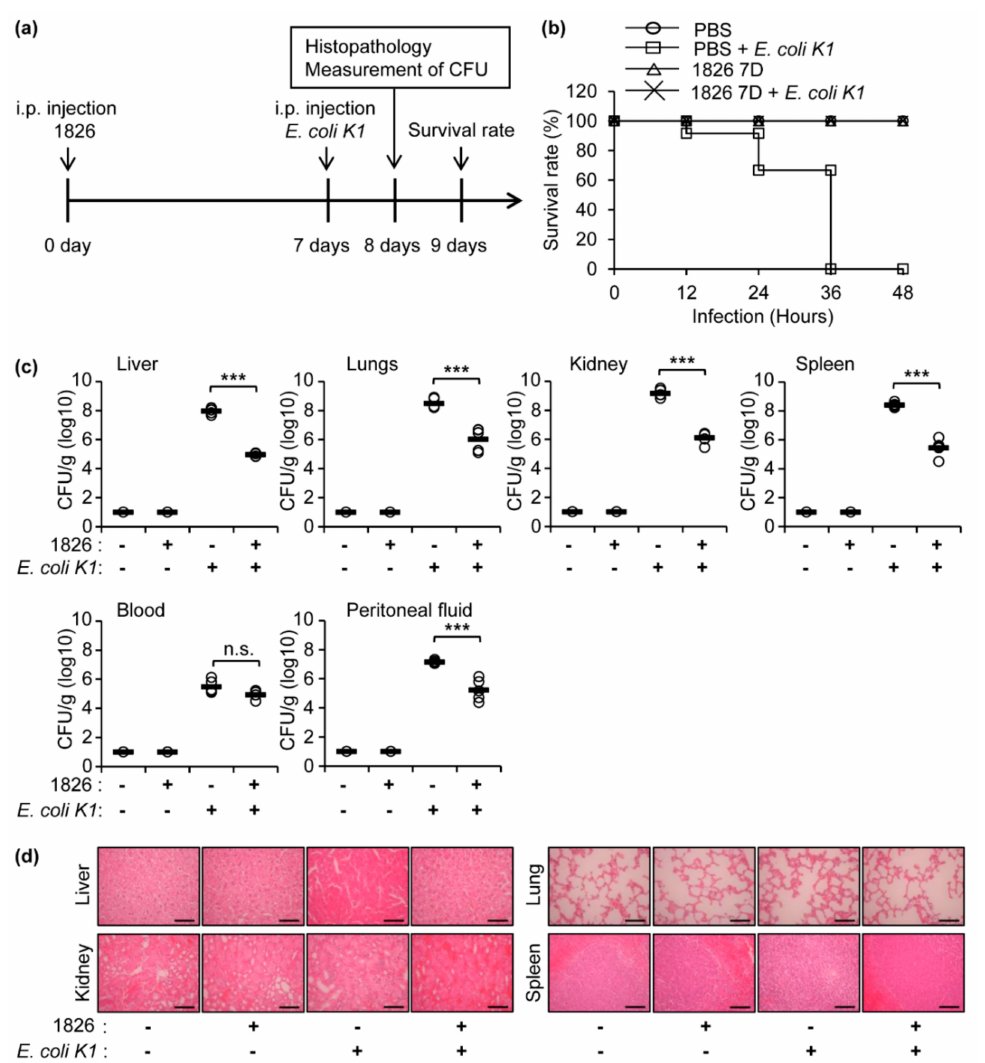
Figure 1. Protective e ff ects of CpG-DNA in mice from peritoneal E. coli K1 infection. ( a ) Schematic diagram of the experimental process is shown. BALB / c mice were i.p. injected with PBS or CpG-DNA 1826 (2.5 mg / kg mouse). After seven days, the mice were i.p. injected with PBS or E. coli K1 (1 × 10 6 CFU / mouse). ( b ) Survival of the mice was monitored for 48 h after E. coli K1 infection. The rate of surviving mice in each group is depicted ( n = 12 / group). ( c ) One day after E. coli K1 infection, the indicated organs, blood, and peritoneal fluids were isolated and homogenized in PBS ( n = 5 / group). The homogenates were serially diluted and loaded onto agar plates to measure the E. coli K1 CFU. ( d ) Histopathology of the indicated organs one day after the infection. Scale bar, 10 µ m. 1826, CpG-DNA 1826. D, days. *** p < 0.0005. n.s., not